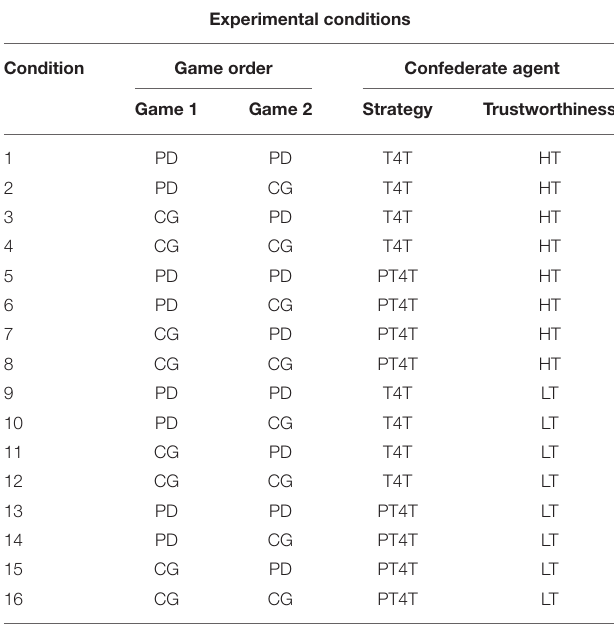
TABLE 4 | The 16 conditions to which participants were randomly assigned during the